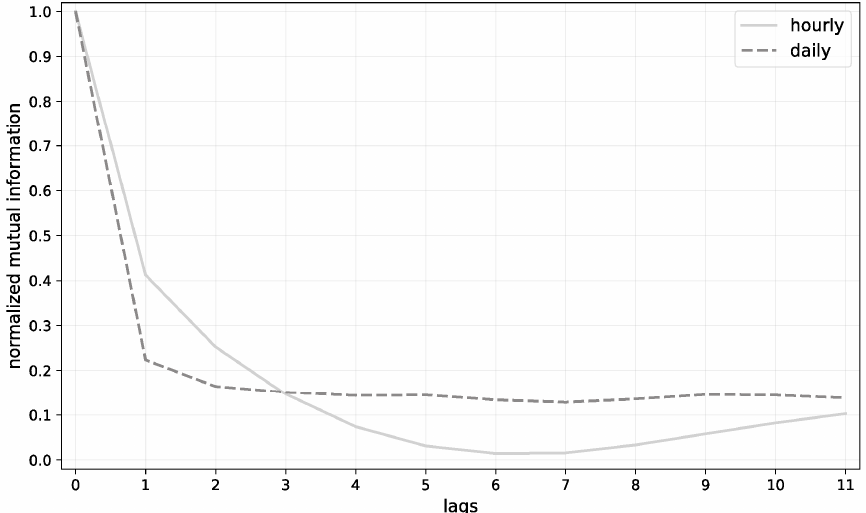
Figure 3. Normalized mutual information of hourly and daily solar irradiance at Como.